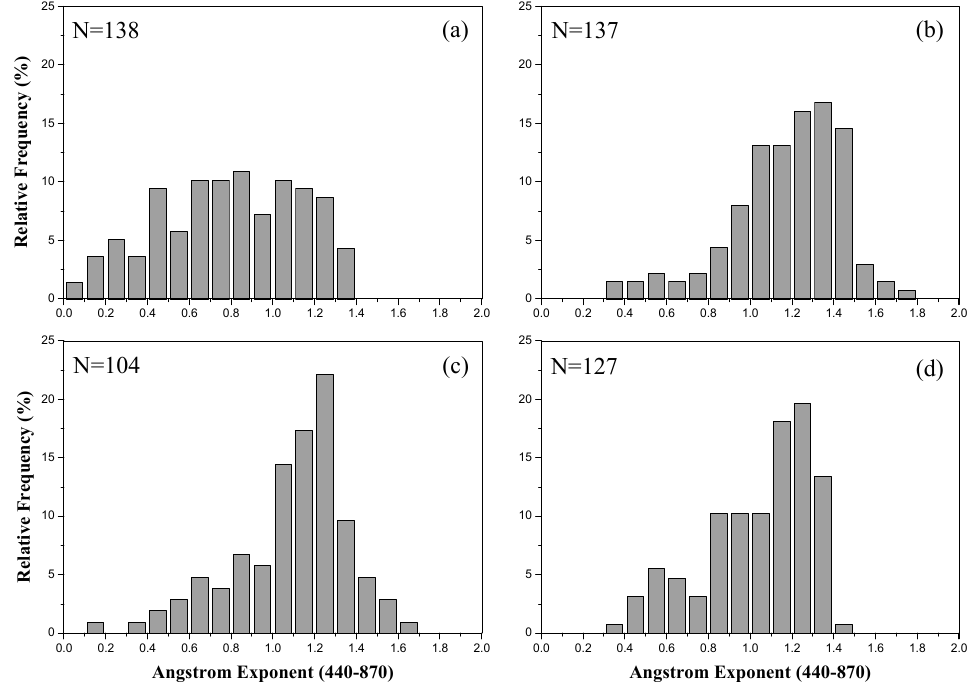
Figure A2. Same as Figure A1 but for Ångstrom exponent (440–870 nm).